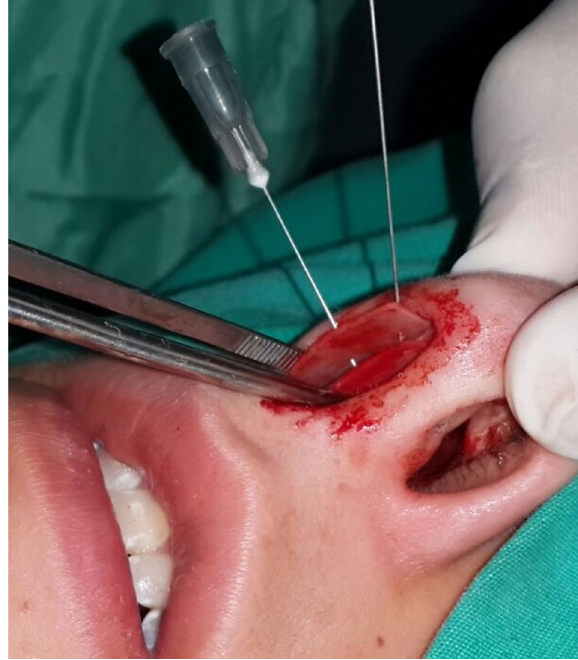
Figure 2 Application of caudal septal extension graft (CSEG).